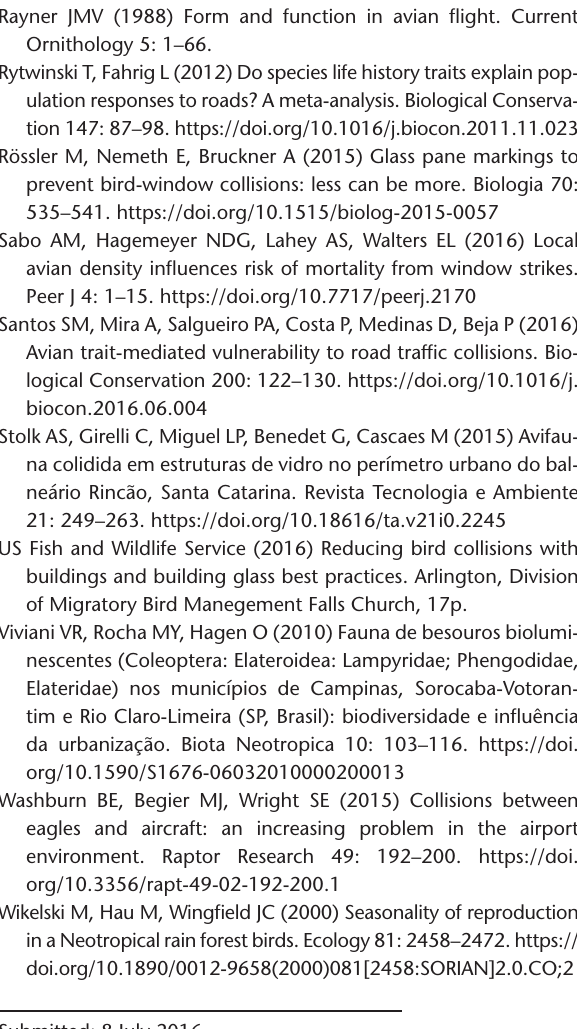
Figure S2. Views from the buildings on the campus of